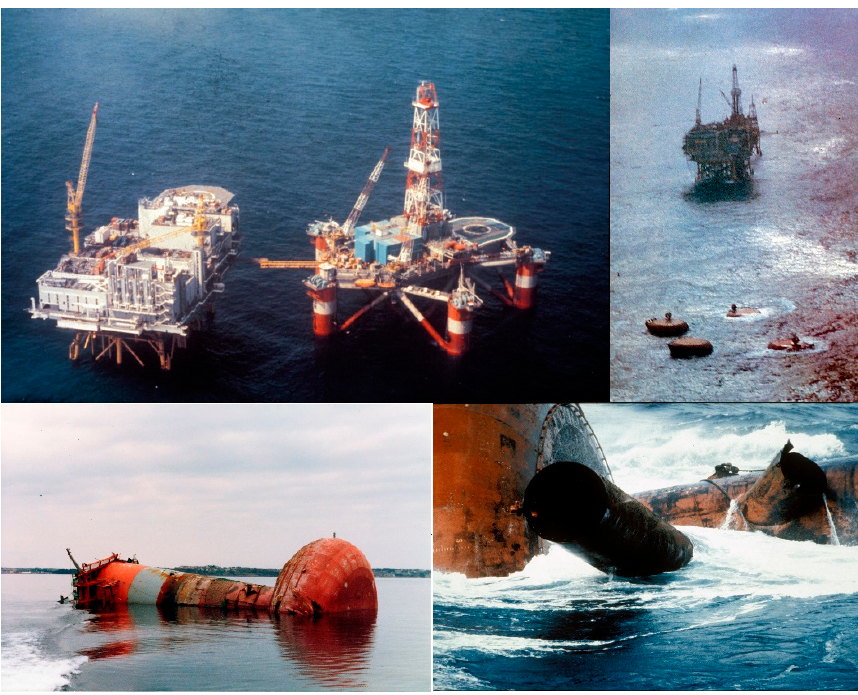
Figure 1. Alexander L. Kielland and capsize of it [2].